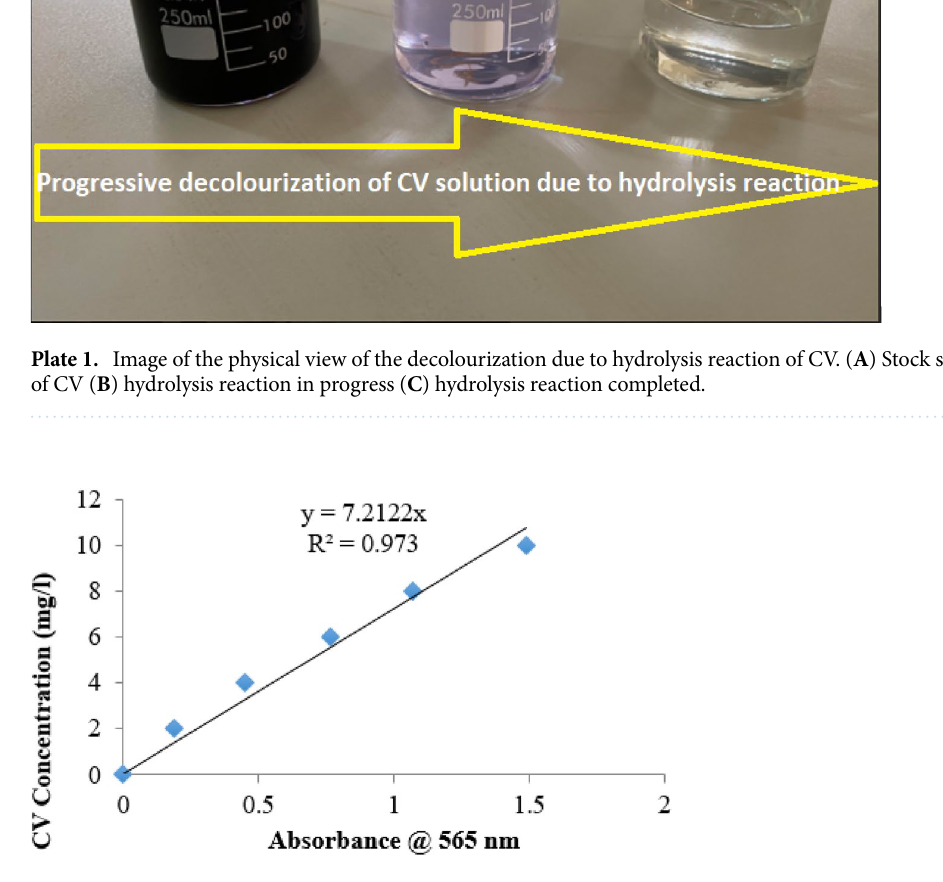
Figure 2. Calibration curve for the concentration of CV at varying spectrophotometer